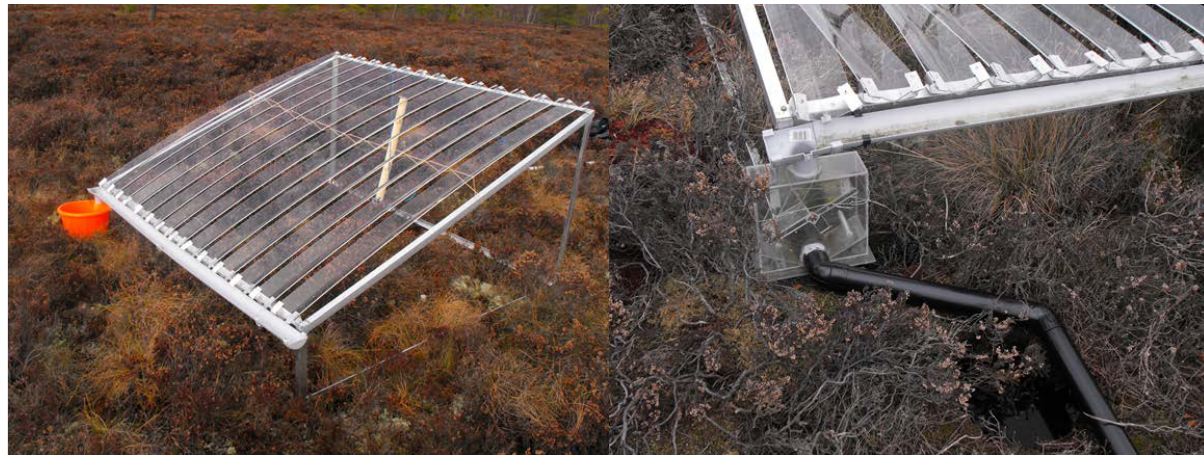
Figure 1. Design of the rainfall shelters showing the arrangement of the roof drainage